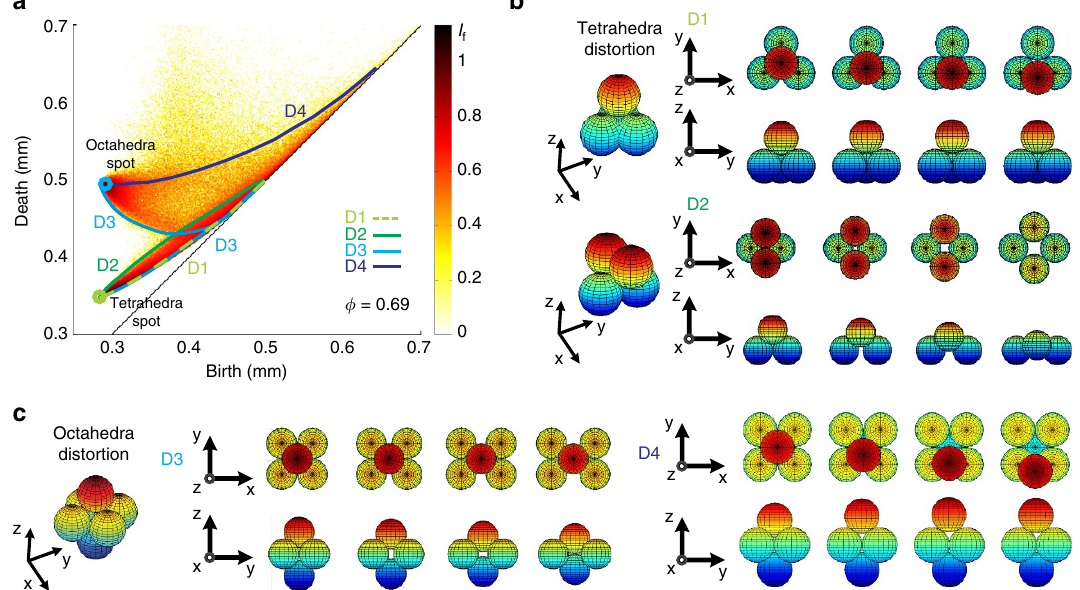
Figure 6 | Grain-scale tetrahedral and octahedral formation/deformation scenarios. ( a ) PD 2 of a partially crystallized sphere packing with density f ¼ 0.685. The superimposed curves correspond to analytically computed birth–death curves of the deformation scenarios shown in panels ( b , c ). ( b ) Top and side views of D1 and D2 deformations scenarios of a tetrahedral cavity. ( c ) Top and side views of D3 and D4 deformation scenarios of an octahedral cavity. The colour code indicates the relative height of sections of the grain with respect to the horizontal median